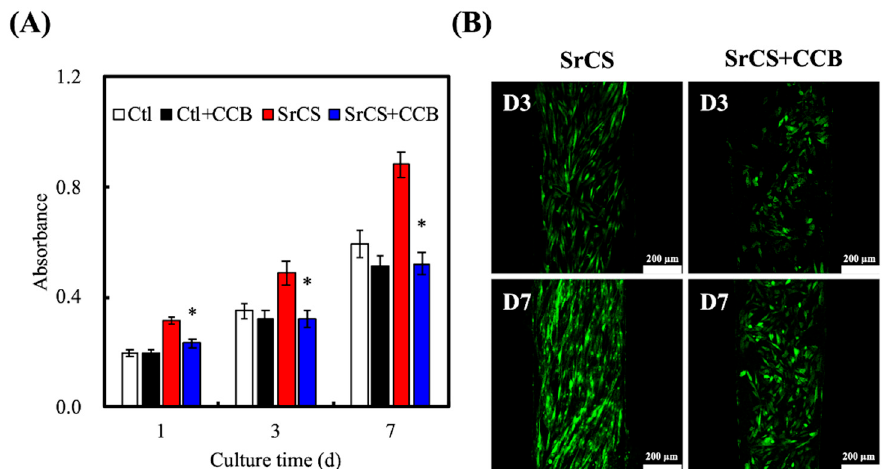
Figure 4. ( A ) Proliferation of WJMSCs on SrCS scaffolds without/with calcium channel blocker (CCB) for different time-points and ( B ) F-actin immunofluorescence staining. Data presented as mean ± SEM, n = 6 for each group. “*” indicates a significant difference ( p < 0.05) when compared to substrate without CCB. Scale bar: 200 µm.